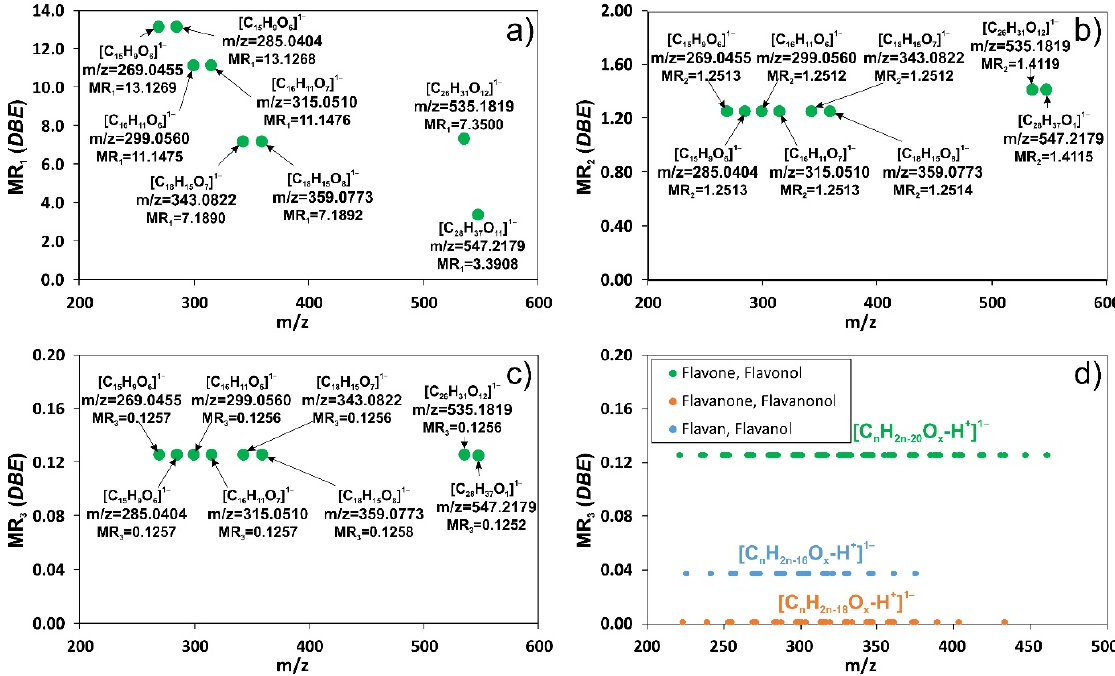
Figure 1. ( a ) MR 1 ( DBE ) versus m/z plot for eight flavonoids detected in the extract of the medical plant yarrow ( Achillea millefolium L.). ( b ) MR 2 ( DBE ) vers us m/z plot for eight flavonoids detected in the extract of the medical plant yarrow ( Achillea millefolium L.). ( c ) MR 3 ( DBE ) versus m/z plot for eight flavonoids detected in the extract of the medical plant yarrow ( Achillea millefolium L.). ( d ) MR 3 ( DBE ) versus m/z plot calculated from the theoretical m/z values of about one hundred flavonoids. ( DBE in parenthesis indicates that the double bond equivalent values were revealed as the characteristic